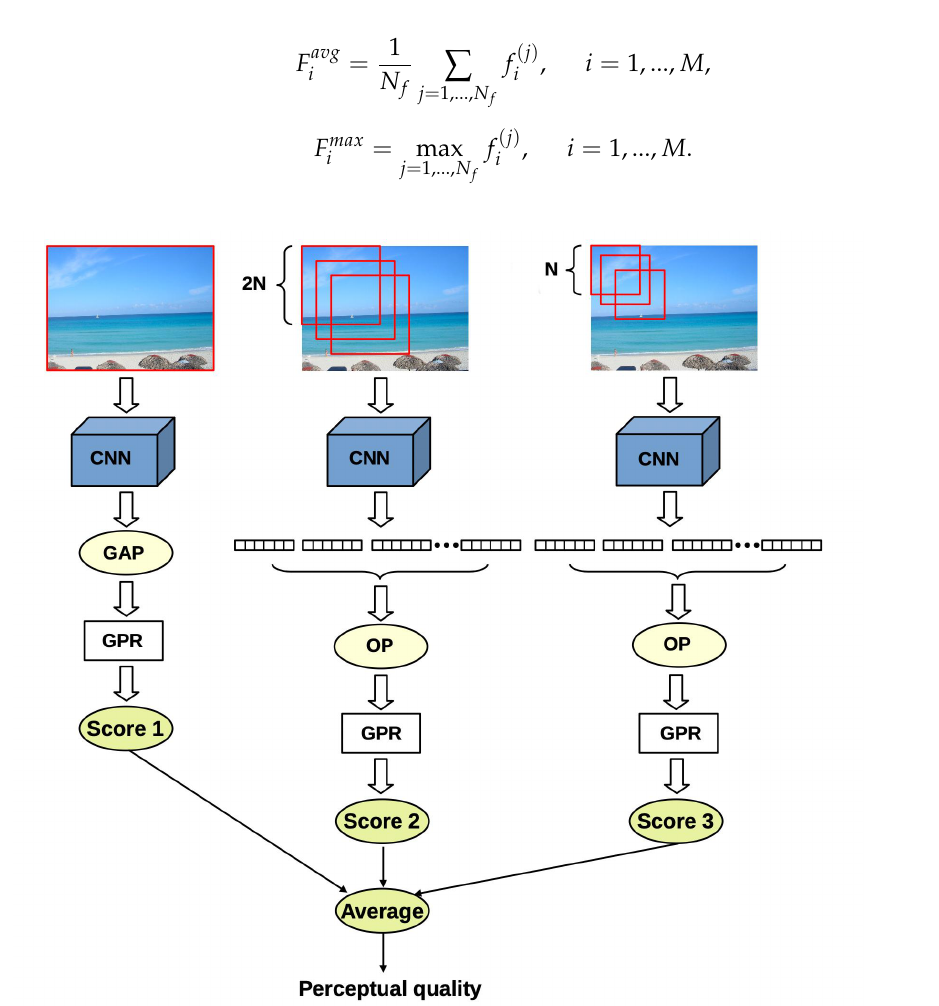
Figure 1. Block diagram of the proposed method. The proposed method extracts deep features from the input image at three different scales. The first scale corresponds to the whole image. At the second scale, square random patches are extracted whose size is the double that of the applied pretrained CNN’s input size, while the patches’ size corresponds to the input of the pretrained CNN at the third